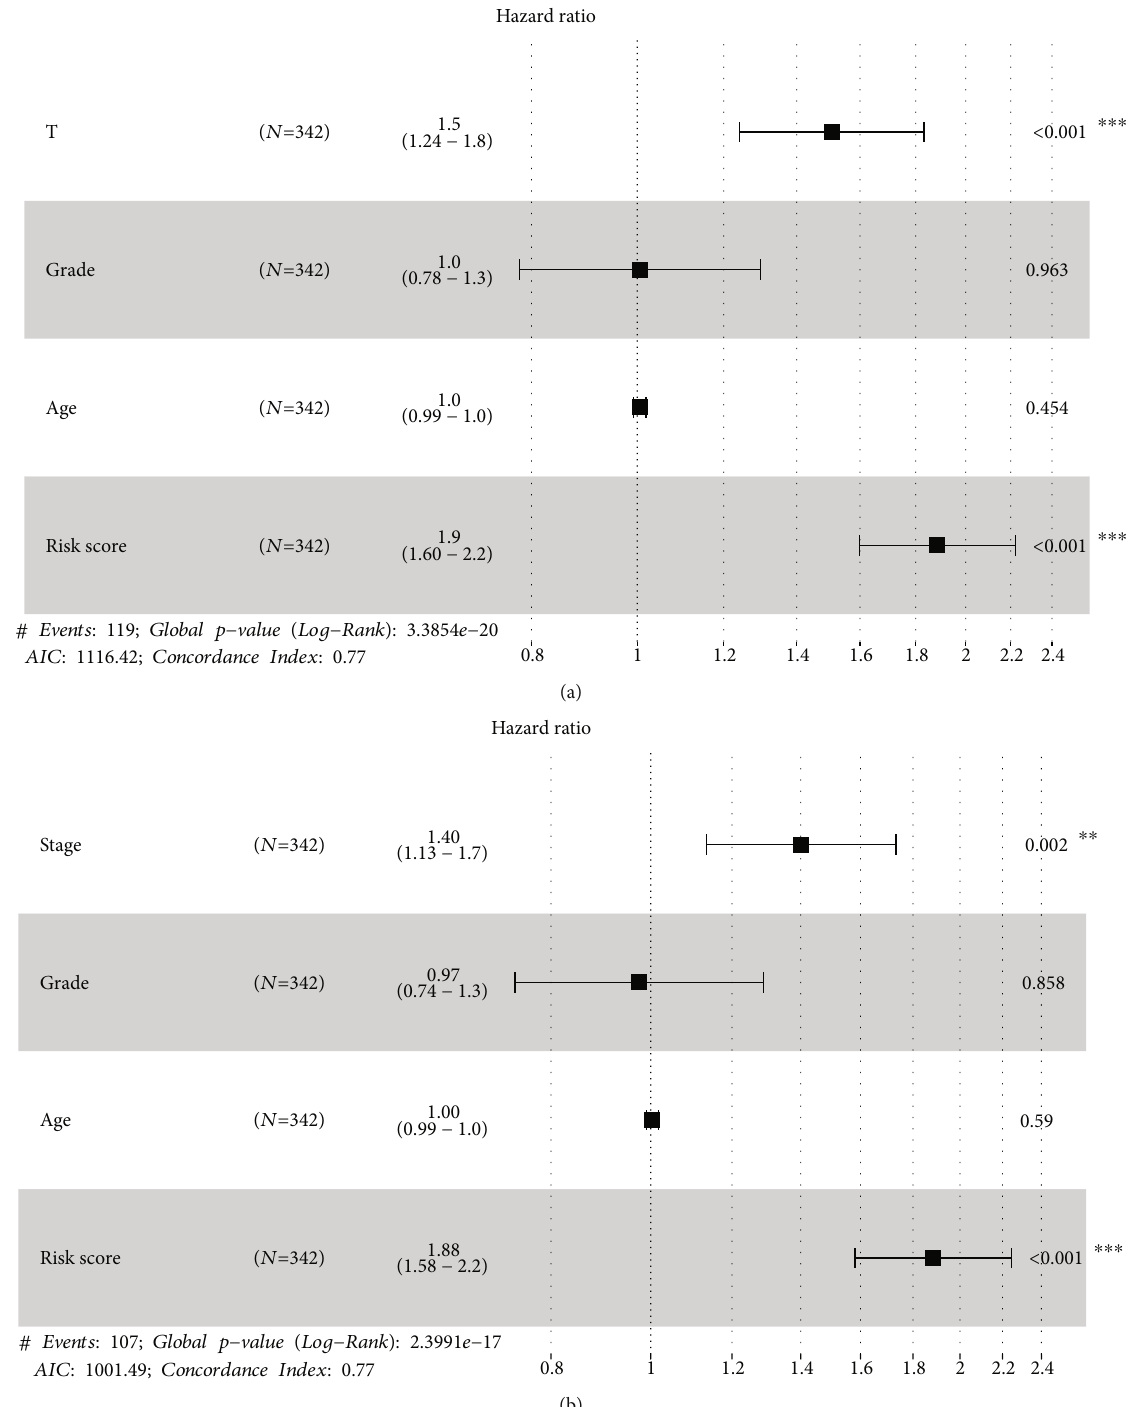
Figure 9: Prognostic value of the nine IPGRs in HCC patients based on forest plots. (a) Clinical features (T, grade, and age) and risk score were analyzed to assess the hazard ratio for HCC patients. (b) Clinical features (stage, grade, and age) and risk score were analyzed to assess the hazard ratio for HCC